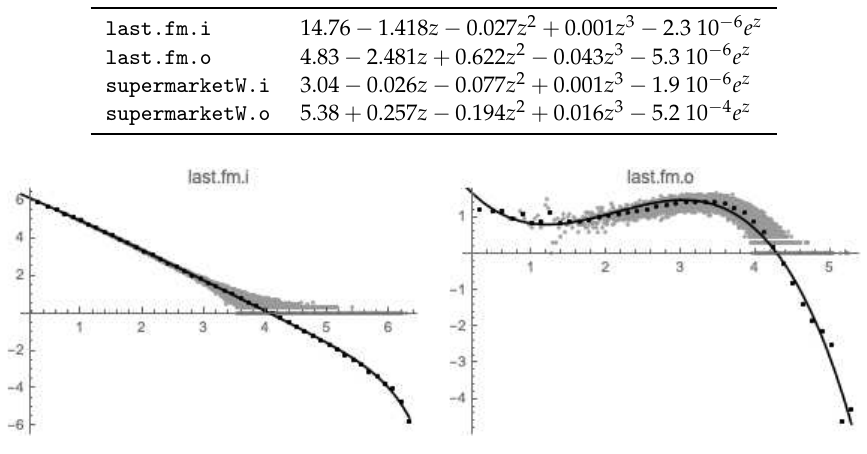
Figure 8. Log-log solutions of last.fm.i ( on the left ) and of last.fm.o ( on the right ).